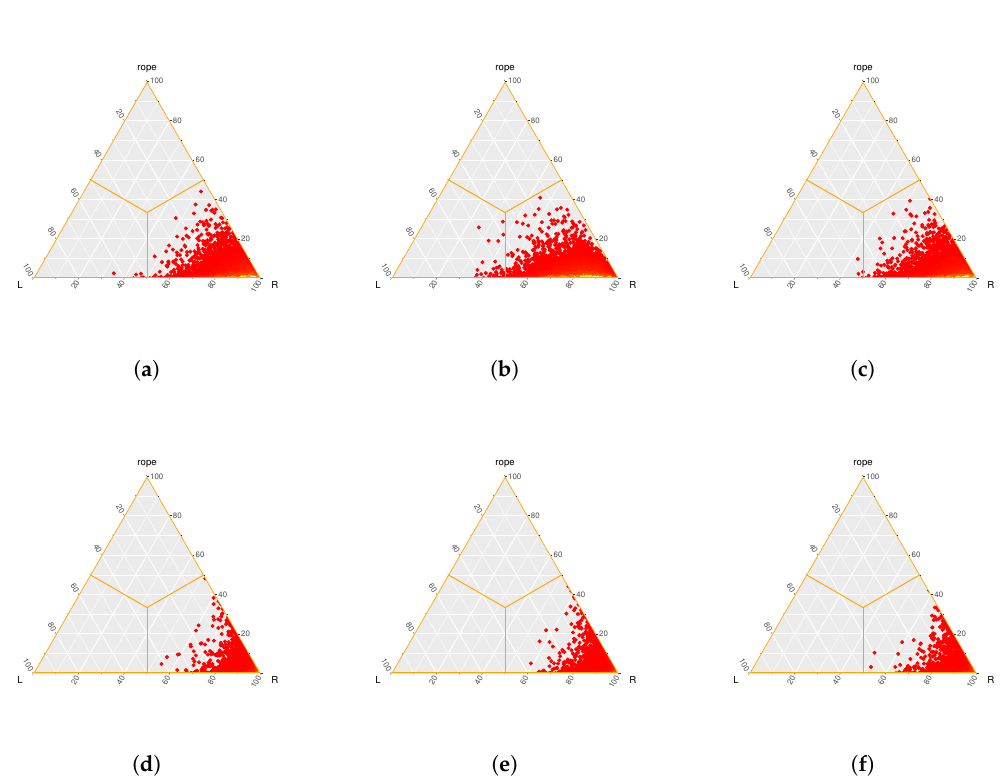
Figure 2. Bayesian Sign test comparing AA- k NN(L) vs. ProLSFEO-LDL(R). ( a ) Chebyshev Distance. ( b ) Clark Distance. ( c ) Canberra Metric. ( d ) Kullback–Leibler Divergence. ( e ) Cosine Coefficient. ( f ) Intersection Similarity.